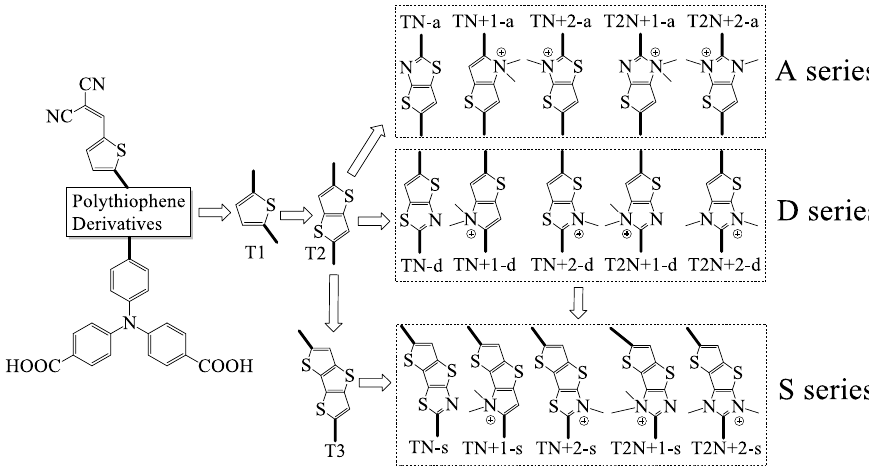
Figure 1. Molecular structures of the investigated dyes.